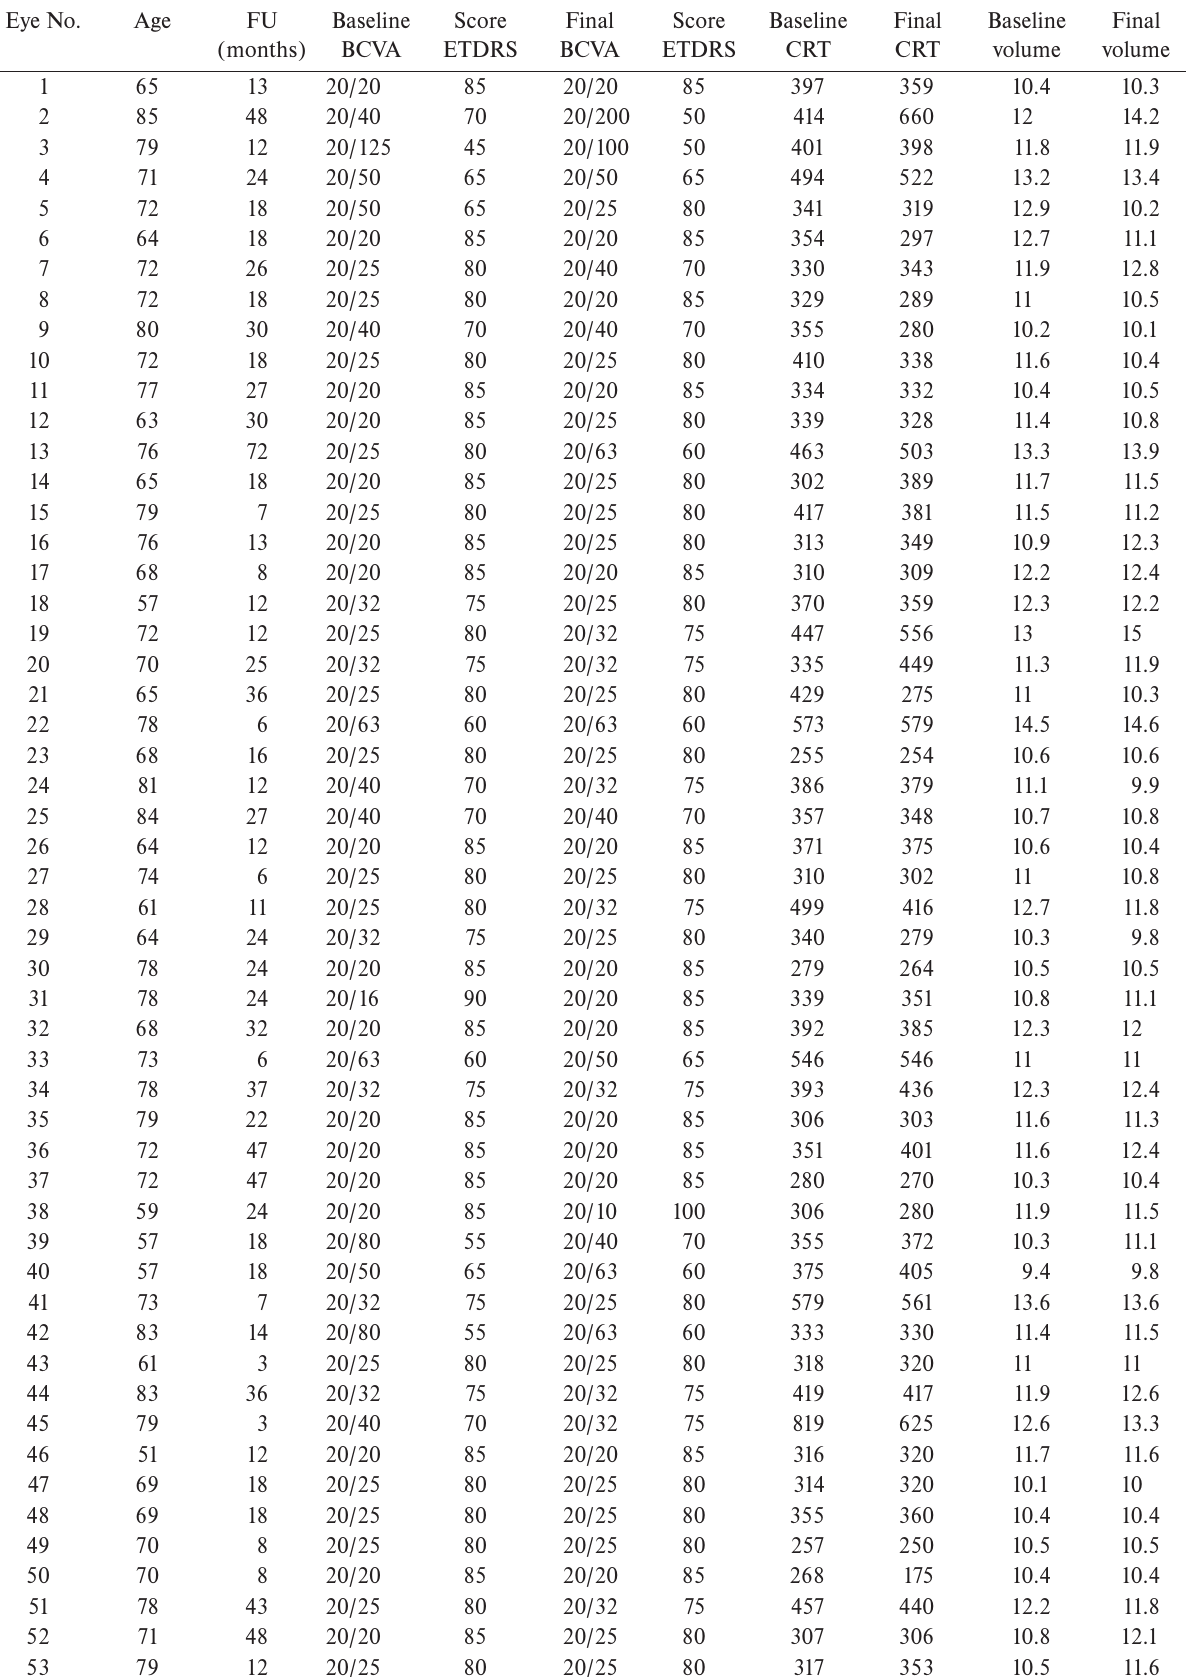
Table 1. Input and output parameters of the cohort under